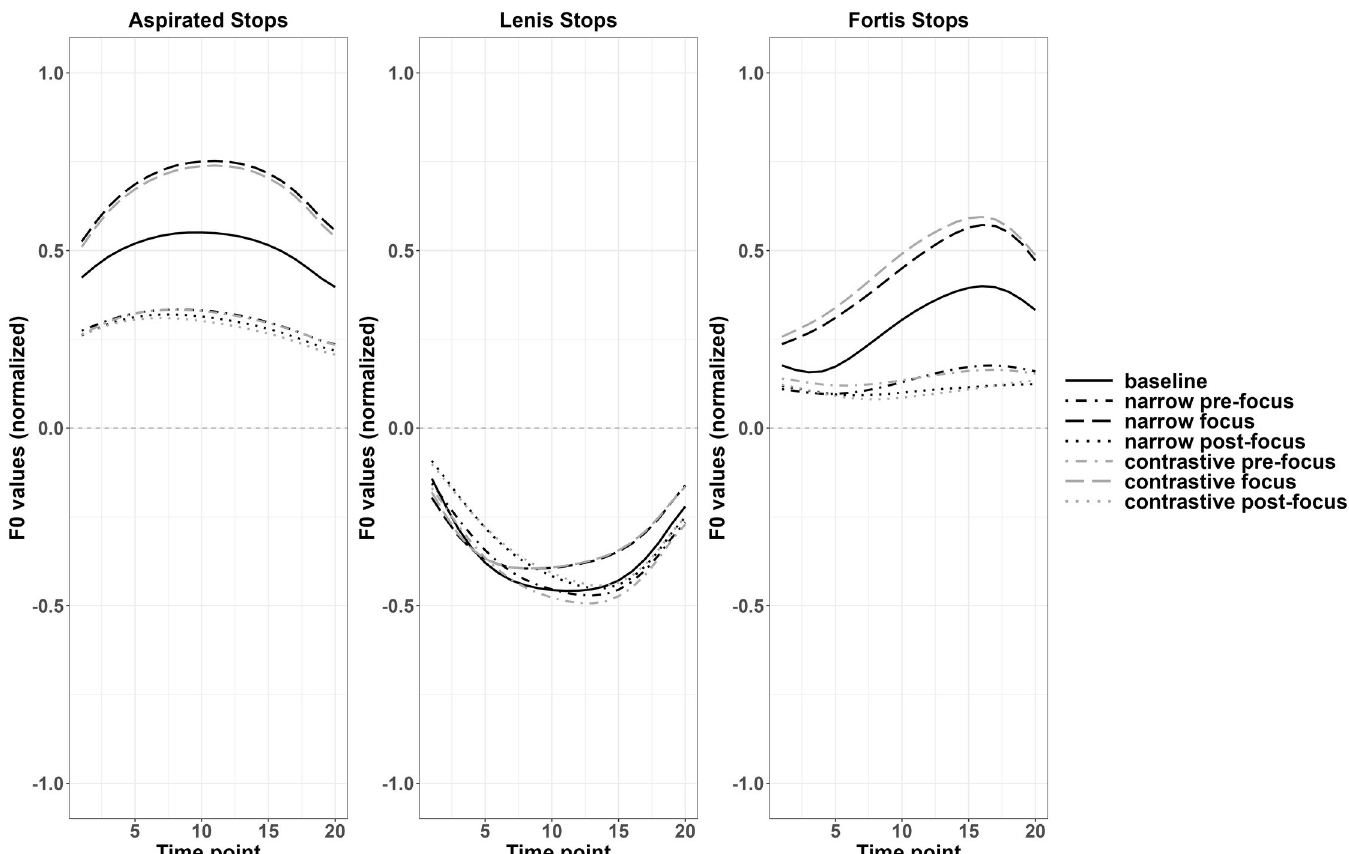
Fig 2. Normalized f0 contours of monosyllabic targets across various discourse conditions (Korean).